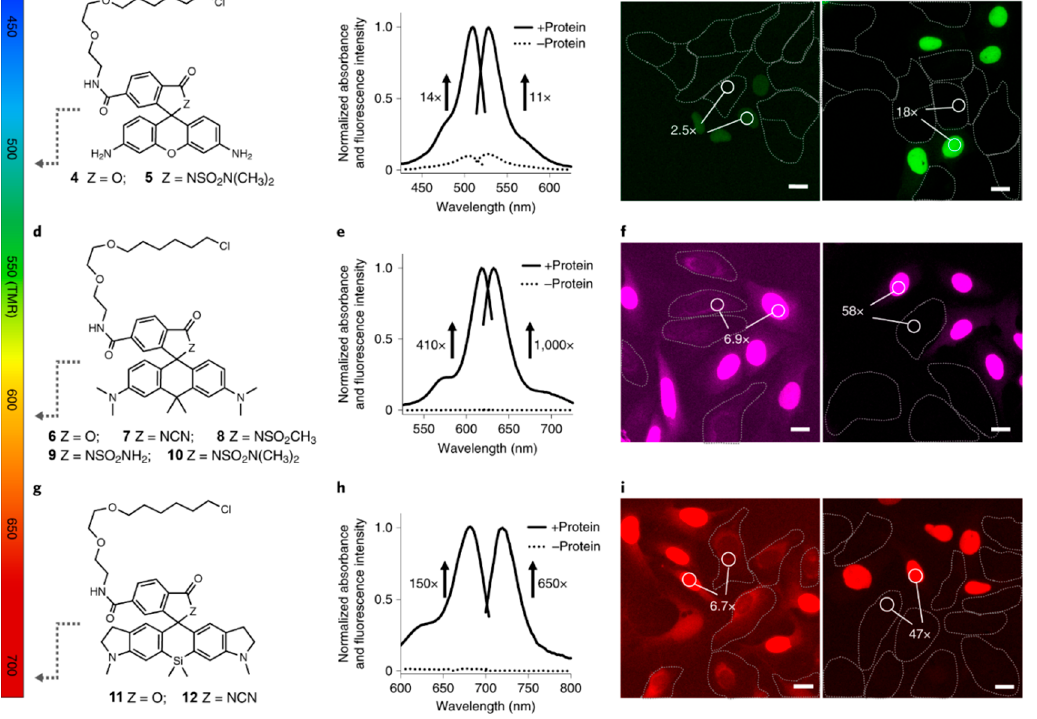
Figure 11. Cell-permeable probes with wavelengths that range from cyan to the near-infrared for no-wash live-cell microscopy; ( a , d , g ) Structures of R11, CPy and SiR700 derivatives coupled to HaloTag substrate, ( b , e , h ) Respective absorption and emission spectra of 5 , 10 and 12 ; ( c , f , i ) No-wash live-cell confocal images of co-cultured normal U2OS cells and U2OS FlpIn Halo-SNaP- NLS-expressing cells labelled with 4 , 6 and 11 ( left ) and 5 , 10 and 12 ( right ). Adapted by permission from Nature: Springer, Nature Chemistry [170] Copyright (2019). Scale bars = 20 µm.